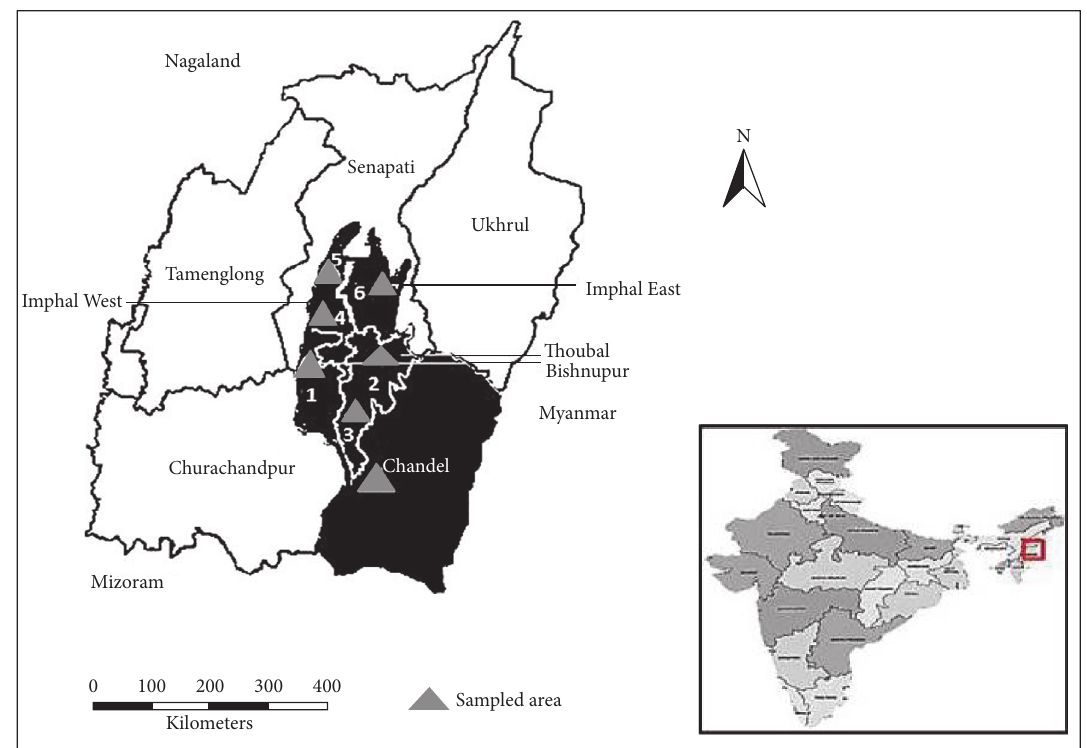
Figure 1: Distribution and location of 7 populations of M. baccifera sampled in 5 districts (blackened area) of